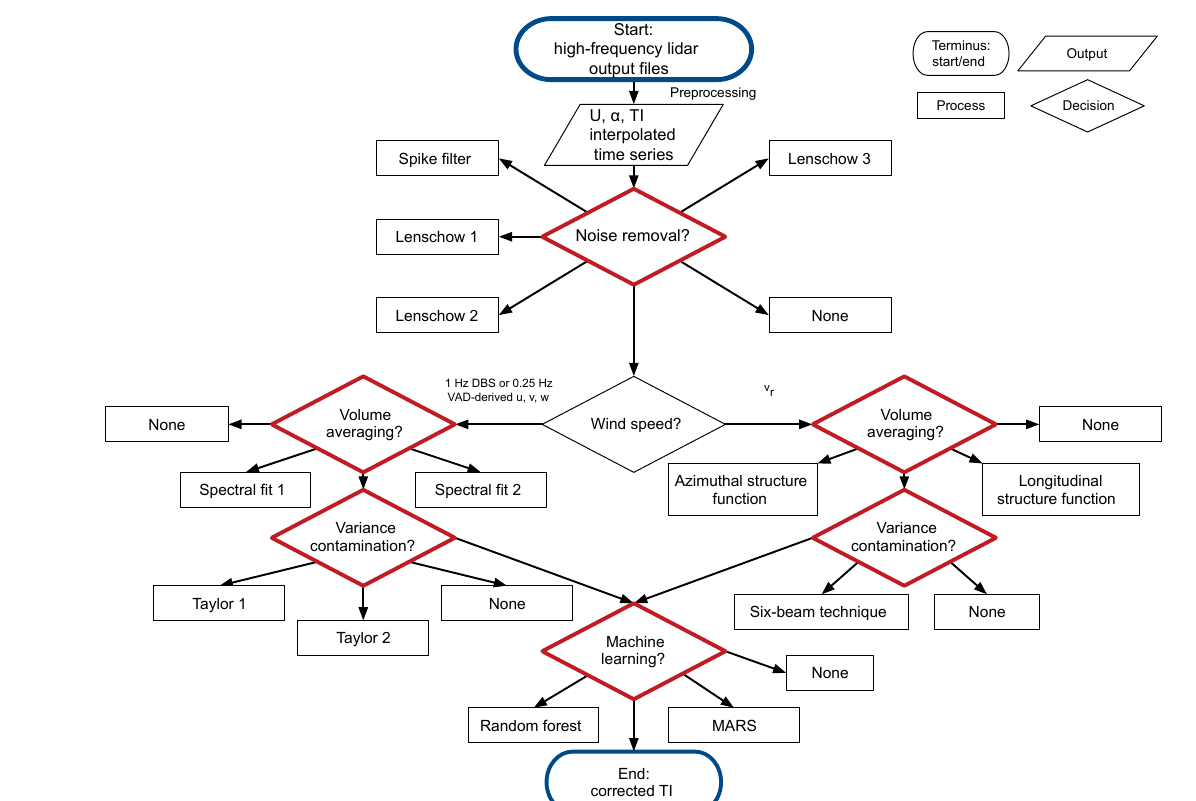
Figure 1. Flowchart depicting different methods for correcting TI with L-TERRA. Starting and ending points are indicated by blue-outlined ovals and modules are indicated by red-outlined